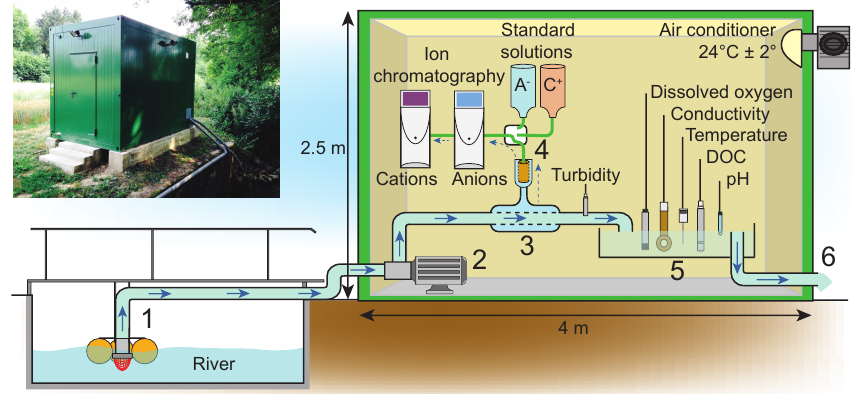
Figure 1. Diagram of the Orgeval River Lab. Bold blue arrows indicate the primary circuit of unfiltered water. Dashed arrows indicate filtered water supplied to IC instruments. (1) The inlet of the primary circuit samples the river at a constant 20cm depth maintained by buoys. Water is first filtered through a < 2mm pore size strainer. The distance between the mouth and the pump is 6m. The primary circuit assembly is almost entirely composed of polyvinyl chloride (PVC) pipes. (2) The electric pump runs continuously at a constant power, leading to a rate of 700L per hour. (3) Almost all the river water just flows through the pipe and remains unfiltered. A fraction is filtered through a 2µm tangential stainless steel filtration unit, then filtered through a 0.2µm cellulose acetate frontal filter prior to being delivered to IC instruments at a flow rate of 1L per hour. (4) A multiport valve before introduction to the IC instruments allows for switching between filtered river water and standard or blank solutions. (5) All probes are deployed in an overflow tank of 5L of unfiltered river water. (6) The outlet of the primary circuit is downstream in the